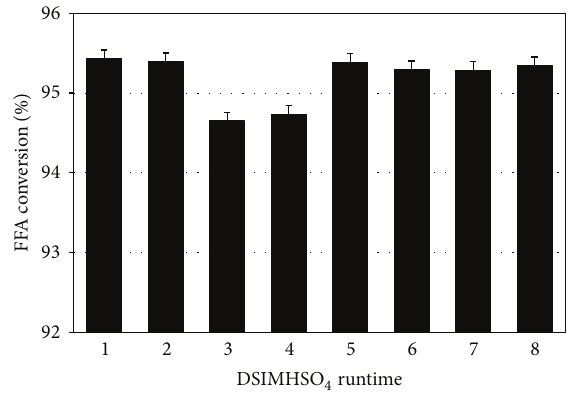
Figure 14: Reusability of DSIMHSO 4